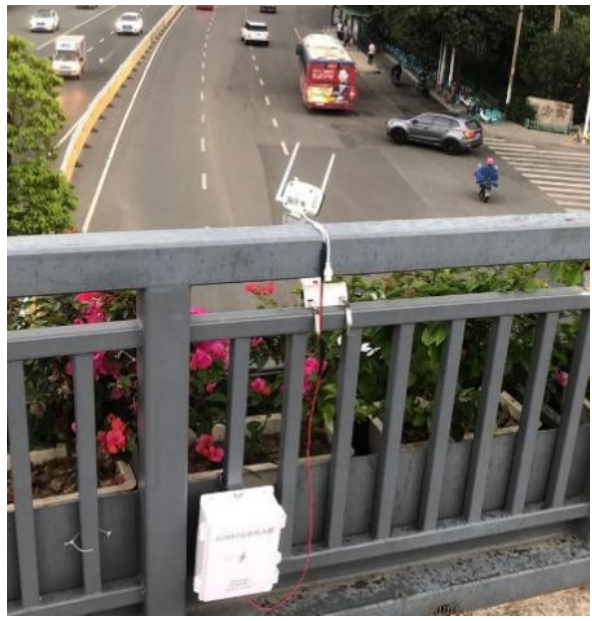
Figure 10. The experimental setup.